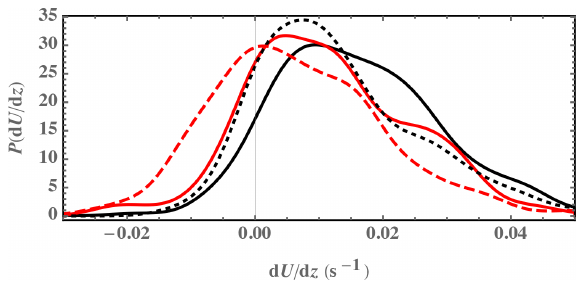
Figure 3. Probability distribution of shear in the periods be- fore (black) and after (red) the detected ramp events. Solid line denotes whole-rotor shear (as U 160m − U 60m ); dotted/dashed line denotes upper-rotor shear ( U 160m − U 100m ).